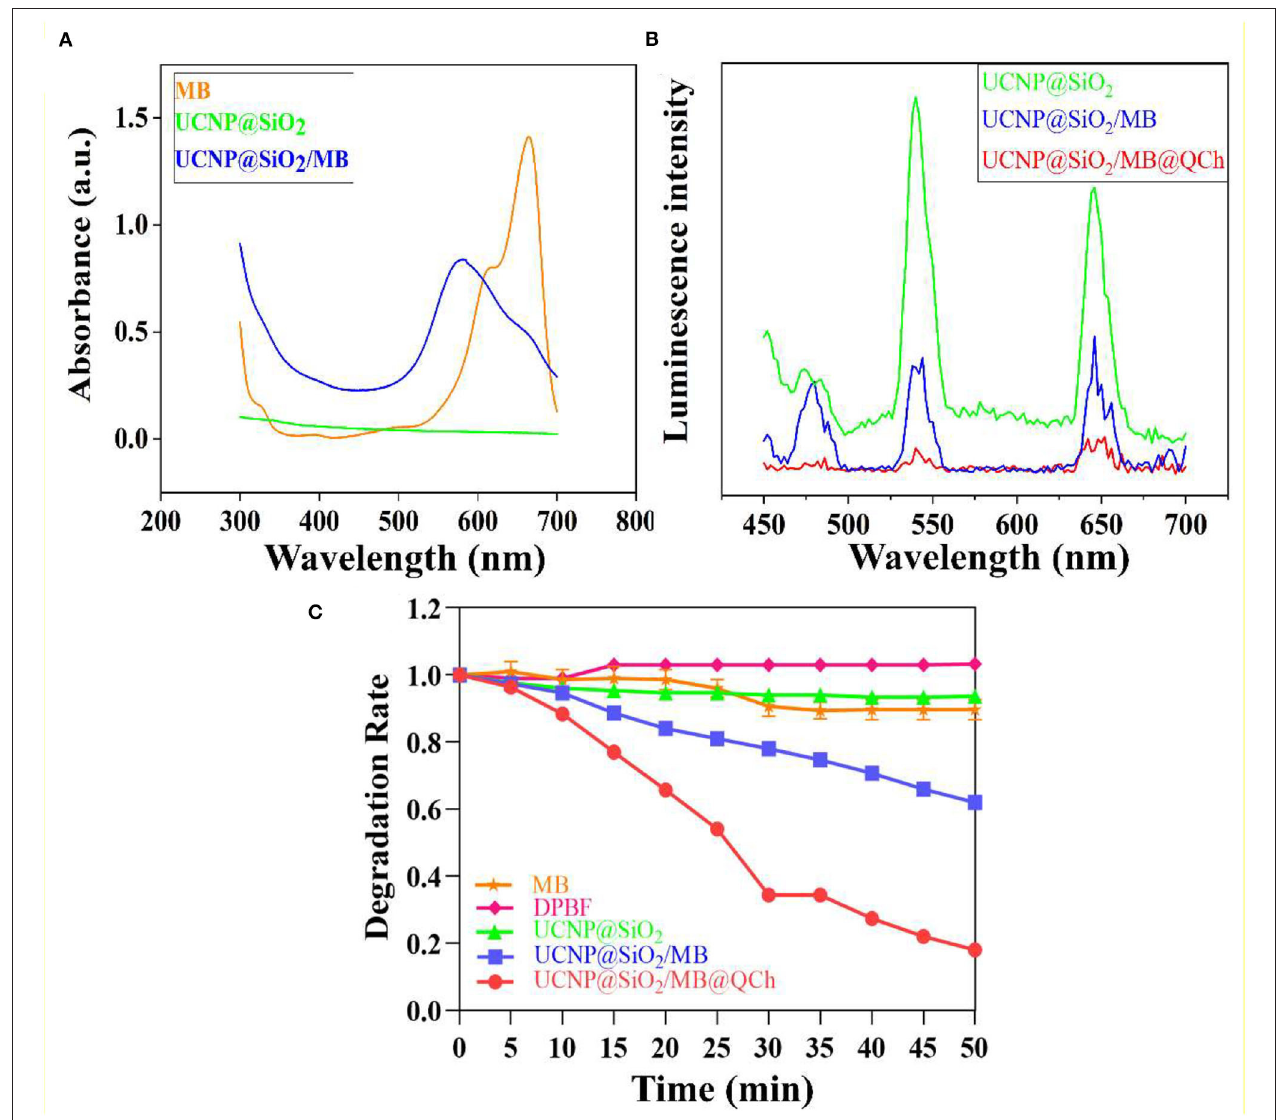
FIGURE 3 | (A) The Uv-Vis spectra of MB, UCNPs@SiO 2 , and UCNPs@SiO 2 /MB. (B) The relative UCL efficiency of UCNPs@SiO 2 -based nanoparticles. (C) ROS detection of MB, DPBF, and UCNPs@SiO 2 -based nanoparticles in